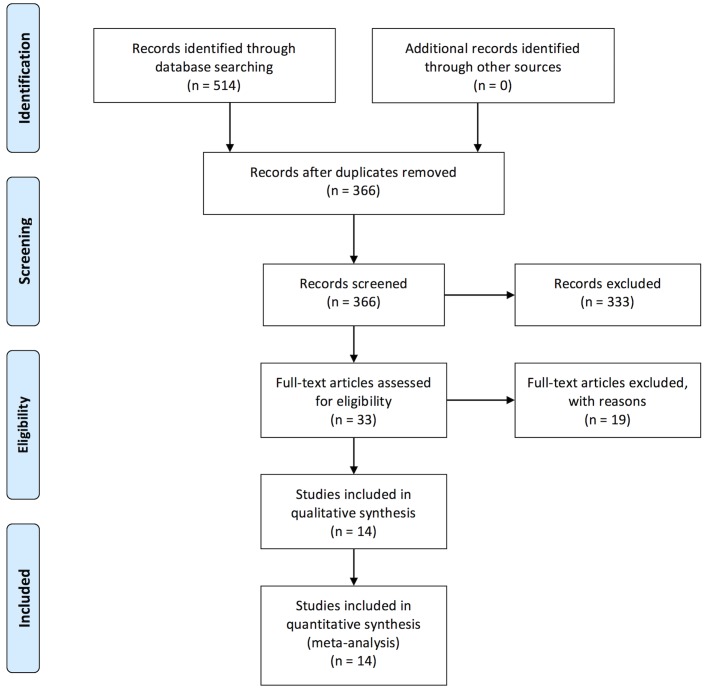
Flowchart depicting the selection process during systematic literature review.